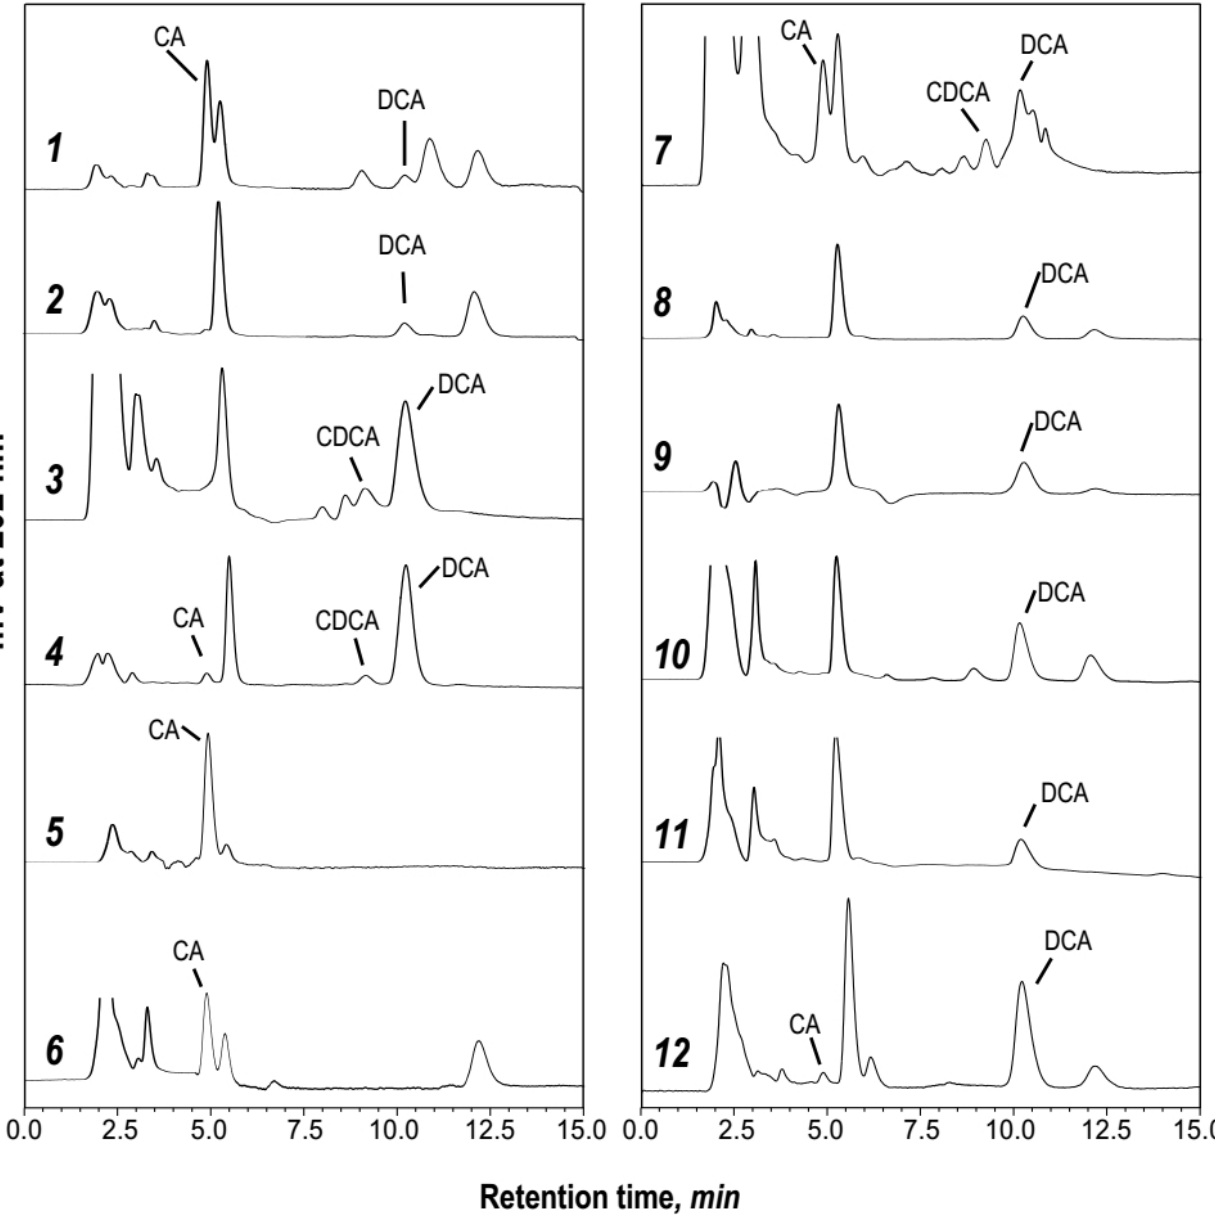
FIGURE 5 - HPLC profile of CA, CDCA and DCA from the biliary bile of the selected animals. Samples of 1 to 12 were cow, sheep, chicken, duck, red tilapia, gourami, common carp, striped snakehead, catfish, pangasius, pomfret, orange-spotted grouper, respectively. Concentrations of samples were 1 mg/mL (1, 2, 4, 5, 6, 8, 9, 12), 5 mg/mL (10, 11), and 10 mg/mL (3,